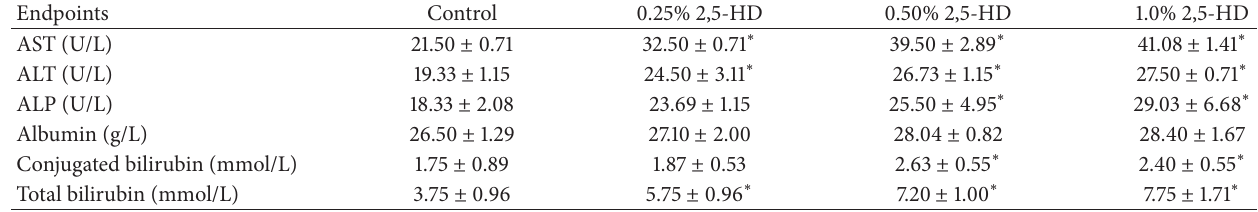
Table 2: Biomarkers of hepatic dysfunction in rats exposed to 2,5-hexanedione for 21 days.